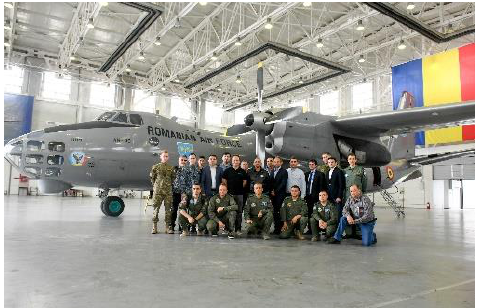
Figure 1. RoDAS Team and the AN30 Observation